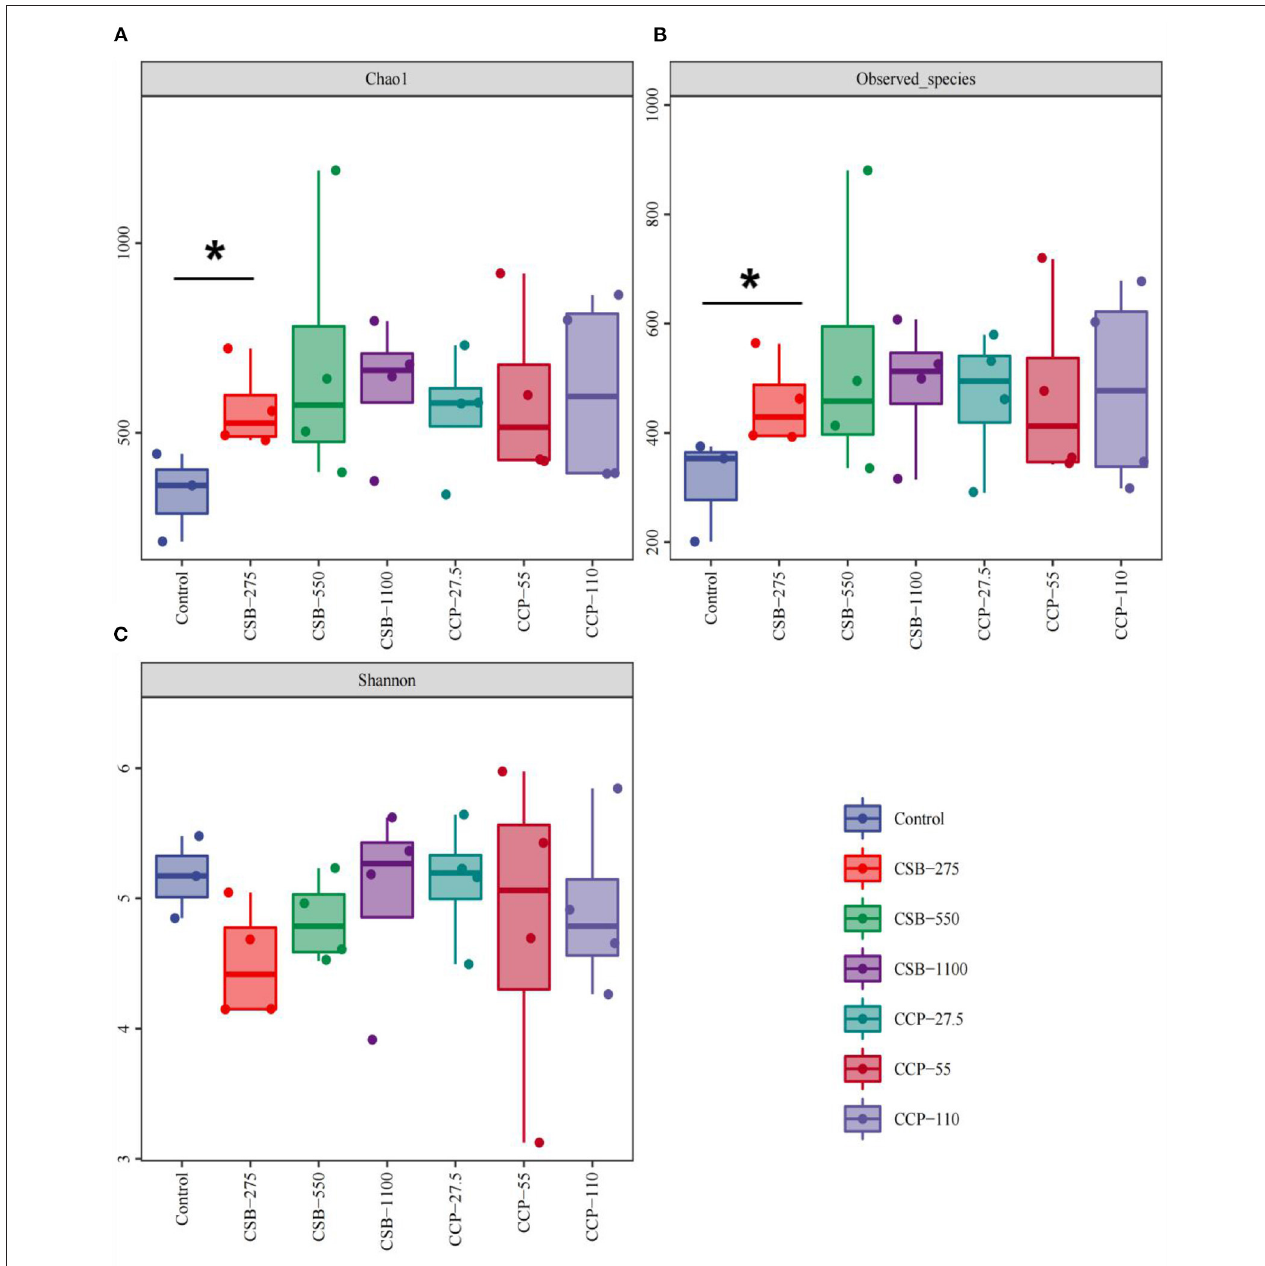
FIGURE 2 | Richness measures (alpha diversity) for the ileal bacterial communities in different concentrations of CSB and CCP. Asterisks denote significant differences between groups ( P < 0.05). (A) Chao 1 indices. (B) Observed species. (C) Shannon